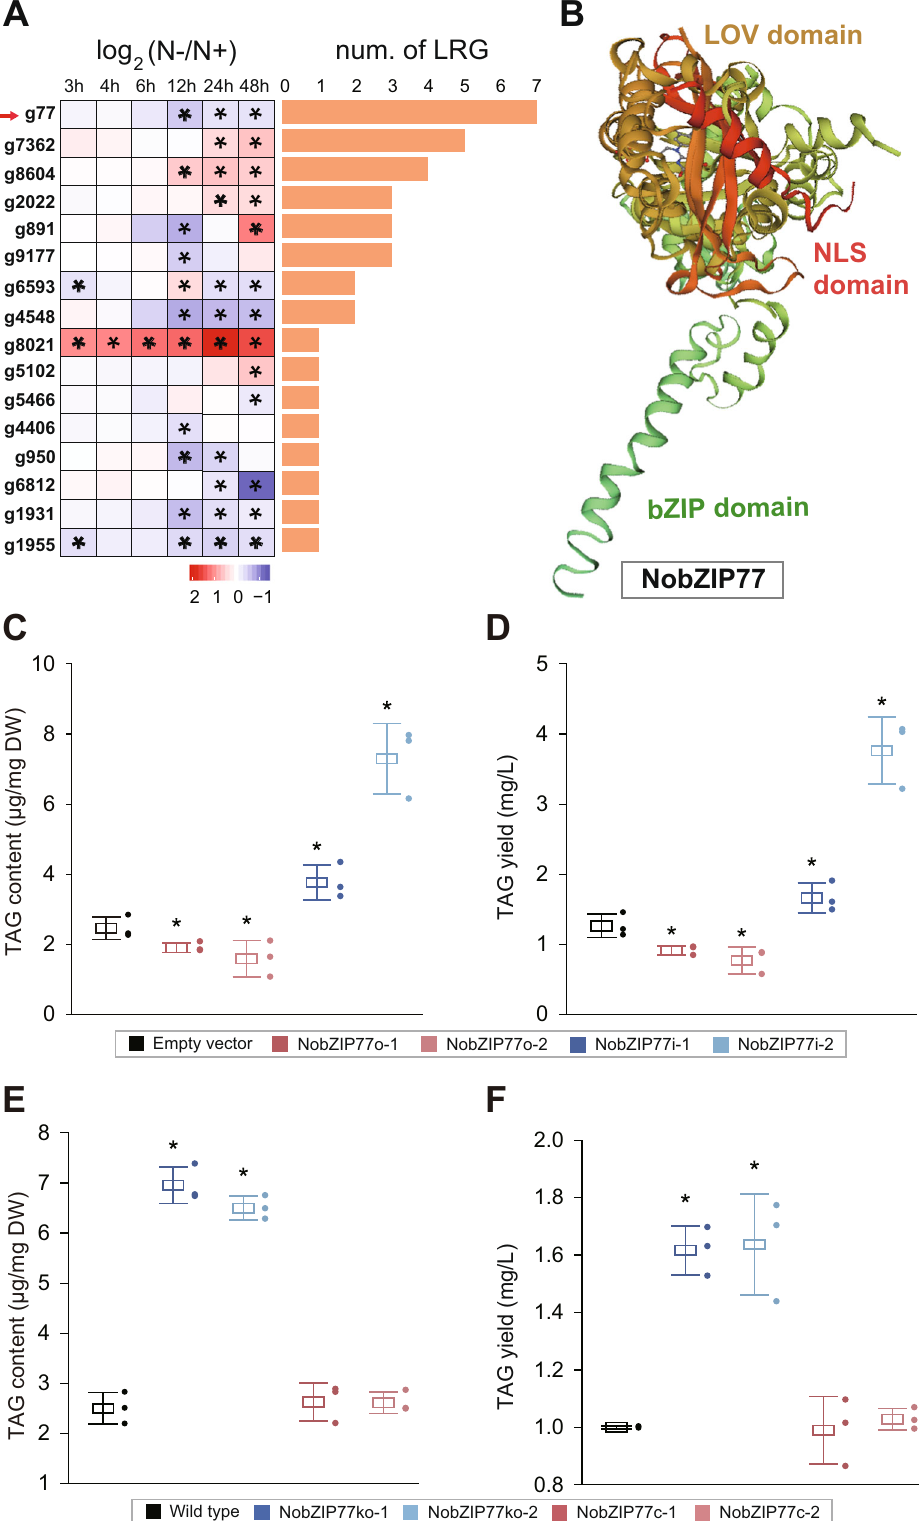
genetically complemented in its knockout lines (Fig. 1D and Supplementary Fig. 5; “ Methods ” ). Importantly, these comple- mentation lines showed essentially identical phenotype to WT in N. oceanica . These results fi rmly pinpoint NobZIP77 as a TF that inhibits N − induced TAG